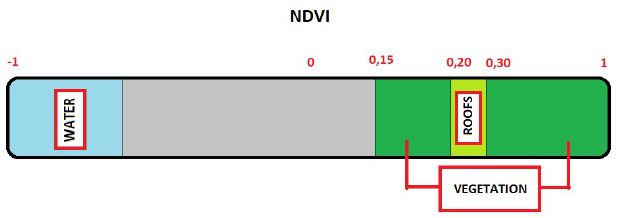
Figure 13: Several classes in the NDVI’s